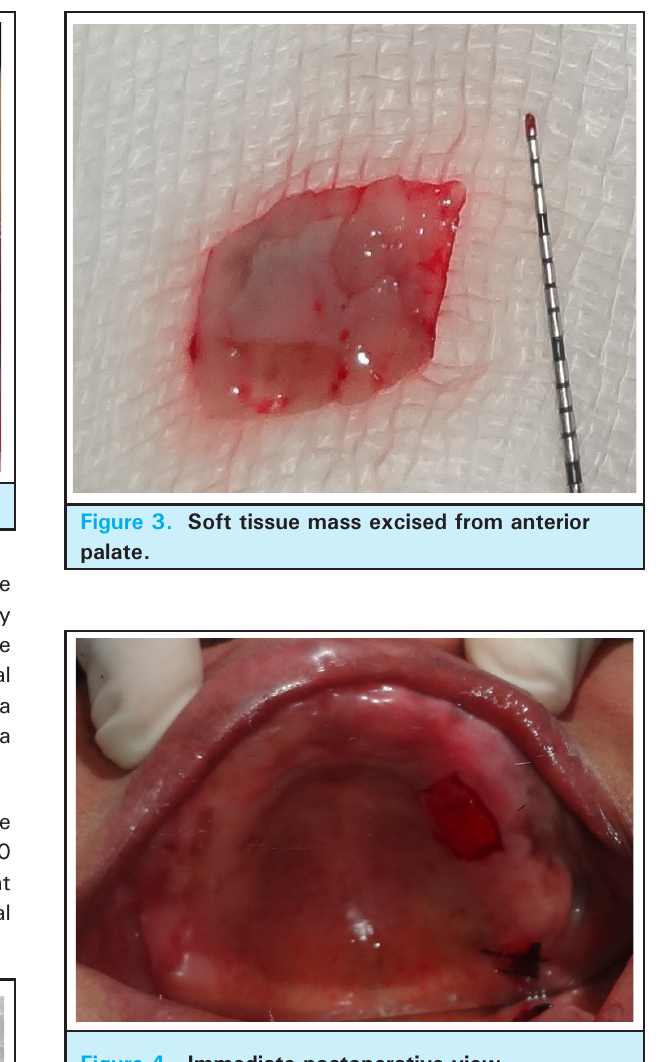
Figure 4. Immediate postoperative